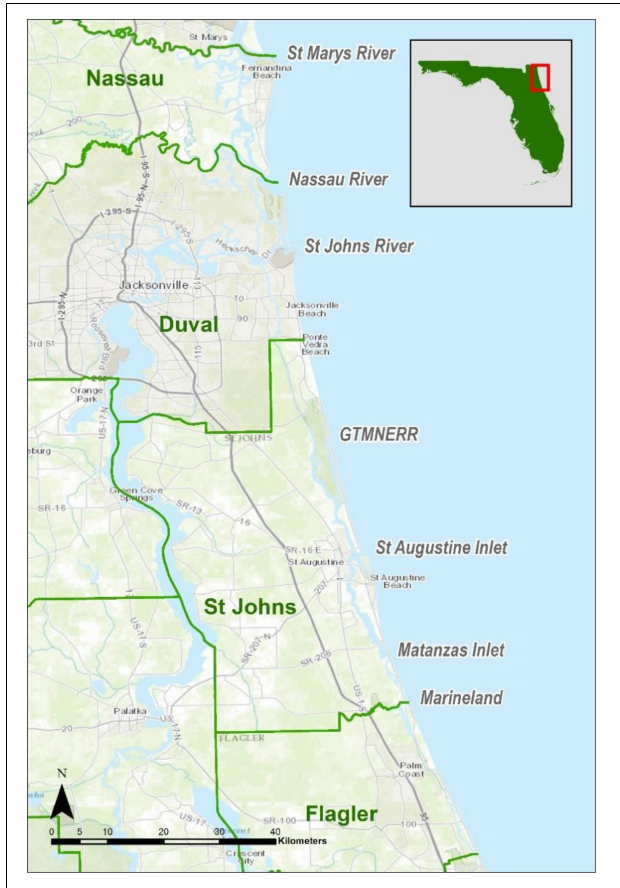
FIGURE 1 | The northeast Florida Diamondback Terrapin study area showing boundaries of the four counties along with major inlets to the ICW.